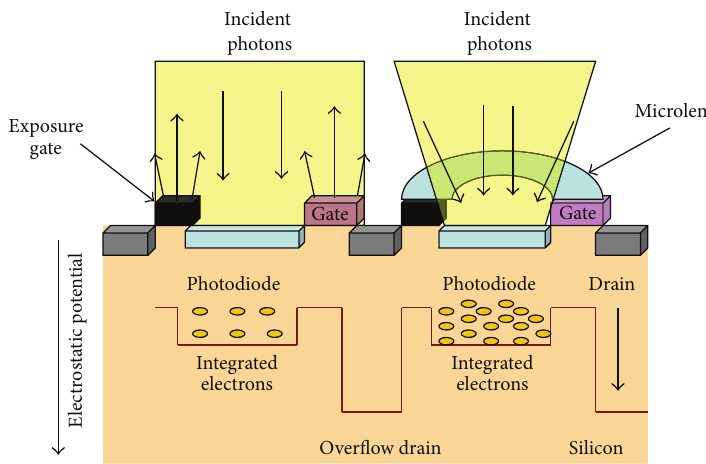
Figure 1: CMOS sensor and microlens (right side) architecture scheme.